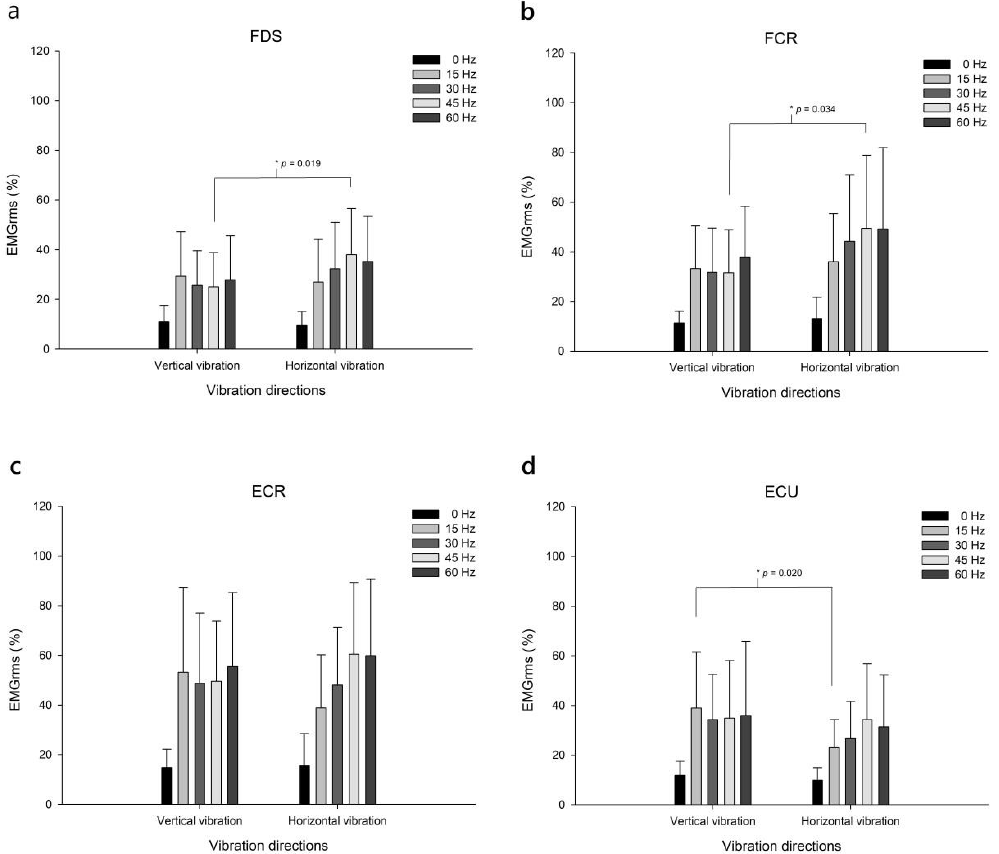
Figure 5. Forearm muscle activation. Muscle activations in the FDS ( a ), FCR ( b ), ECR ( c ), and ECU ( d ) muscles of the forearm at 0, 15, 30, 45, and 60 Hz vibration frequencies in the vertical and horizontal vibration directions. EMGrms, root mean square of surface electromyographic signals. FDS, flexor digitorum superficialis; FCR, flexor carpi radialis; ECR, extensor carpi radialis; ECU, extensor carpi ulnaris.